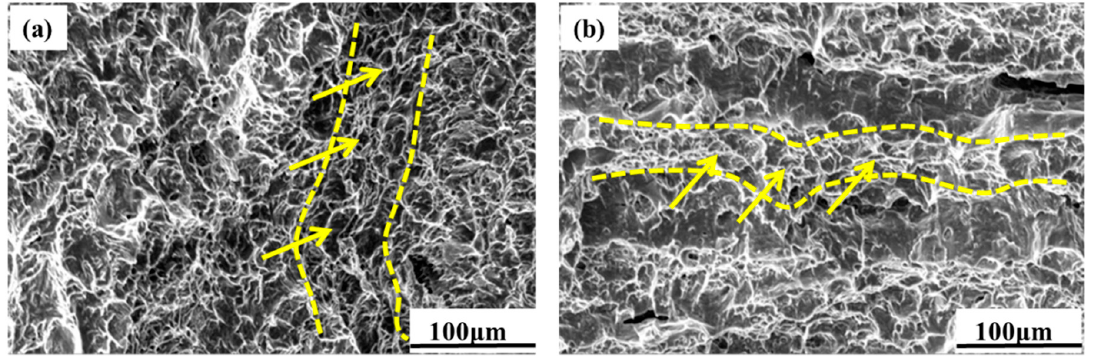
Figure 8. Microtopography of the impact fractures: ( a ) RD-TD specimen; ( b ) RD-ND specimen.